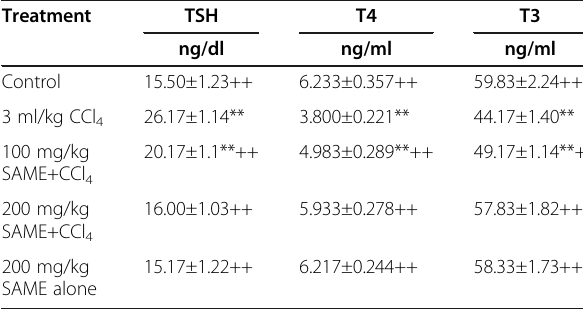
Table 1 Effect of SAME on thyroid hormones TSH, T3, T4